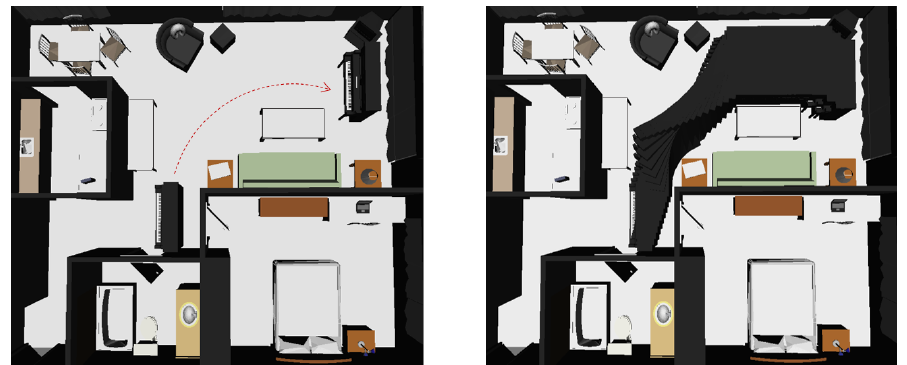
Figure 1. Moving a piano from one corner to another corner using the LLA* algorithm (top view). The left figure shows the start place and the goal place of the piano (from the left corner to the right corner). The right figure shows the composite moving trajectory of the piano without touching the tables and